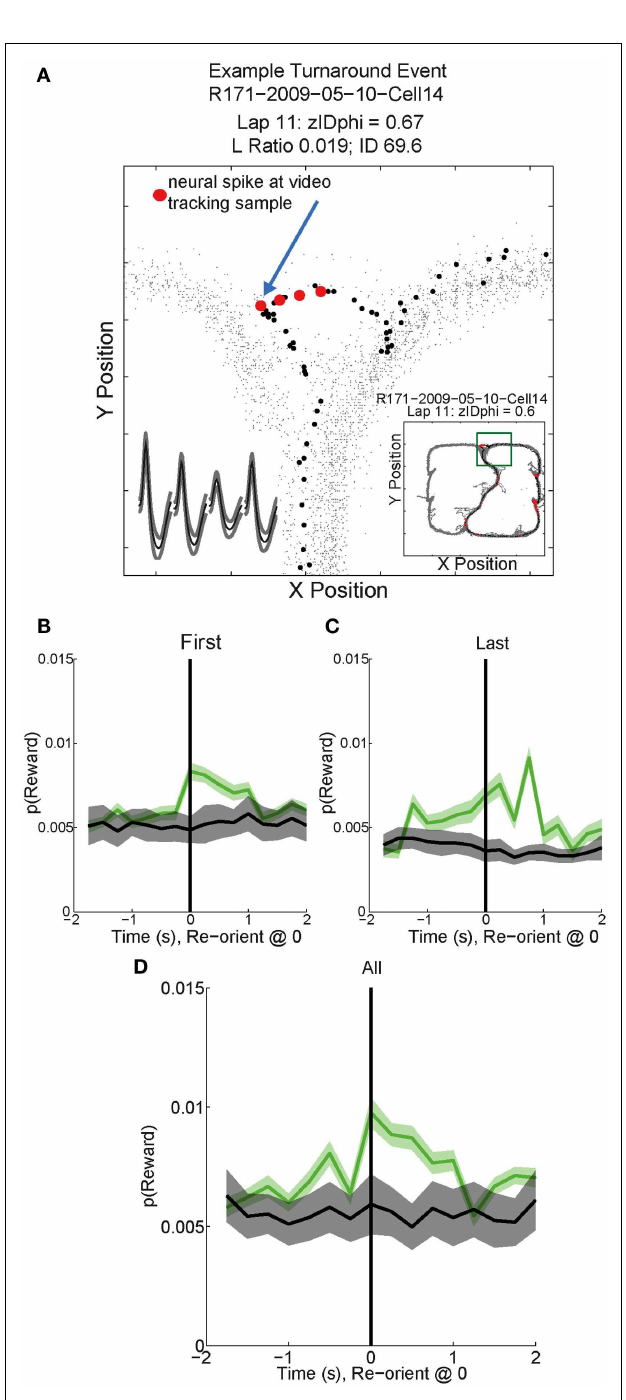
FIGURE 11 | ExampleActivity and decoded p (Reward) duringVTE events. (A) This particular reward responsive cell spiked multiple times duringVTE.The inset shows the average waveforms of this cell for each channel of the tetrode.The behavior demonstrates the typical “head sweep” seen during aVTE event (see Figure 3 ).The red dots indicate neural spikes which are overlaid on top of the behavioral tracking data.The current lap is denoted by black dots. Reorientation is identified by the peak deviation in the pass, indicated by the blue arrow. On many sessions, multiple reorientation events occurred at the choice point. For this figure,